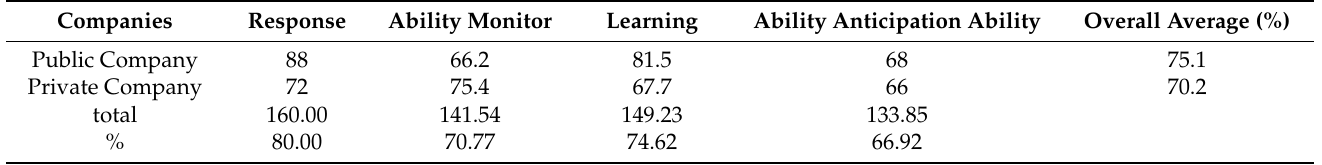
Table 4. Results of RAG calculations in the public and private